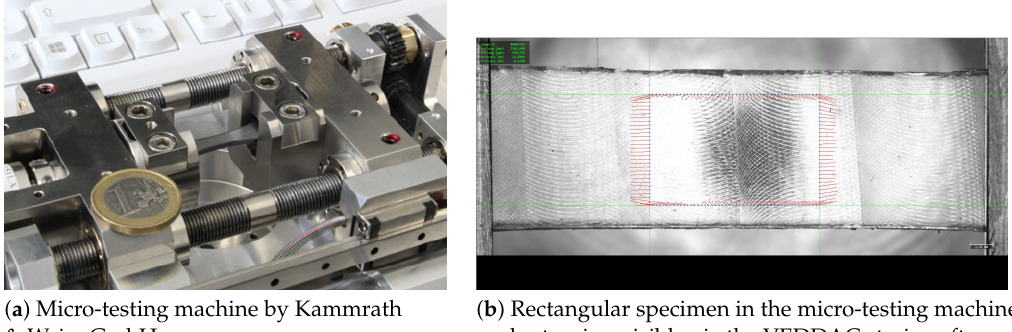
Figure 1. Experimental setting—the micro-testing machine by Kammrath & Weiss GmbH in combination with the CCD camera system by Chemnitzer Werkstoffmechanik GmbH providing load-displacement data, as well as the displacement field on the